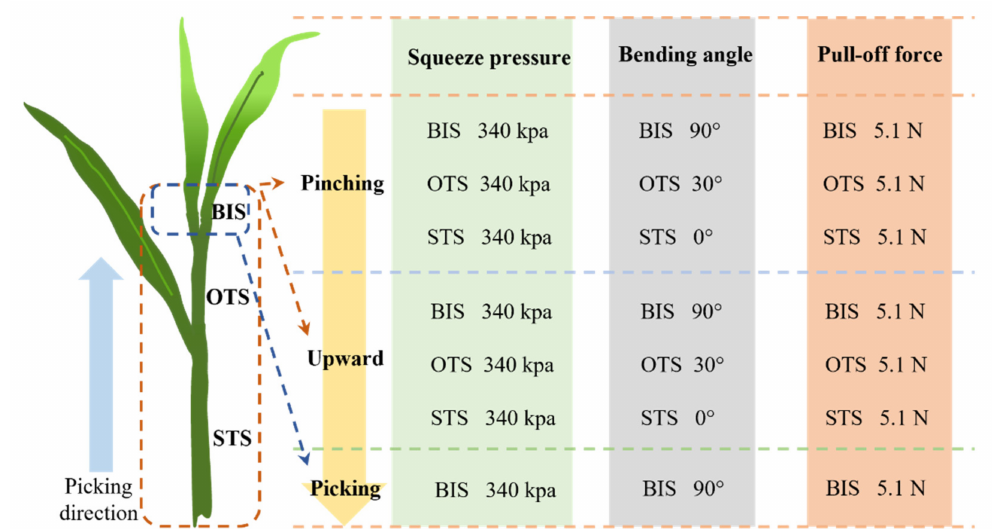
Figure 14. The path of the bionic shoot-picking force. BIS: stalks between buds and leaves; OTS: one and two leaves interstitial stalks; STS: stalks between the second and third